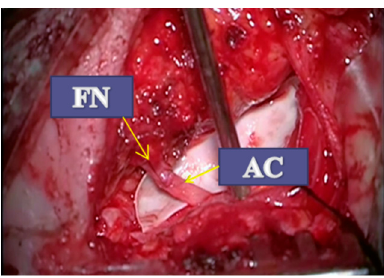
Figure 8. Anastomosis between the ansa cervicalis (AC) and facial nerve (FN).